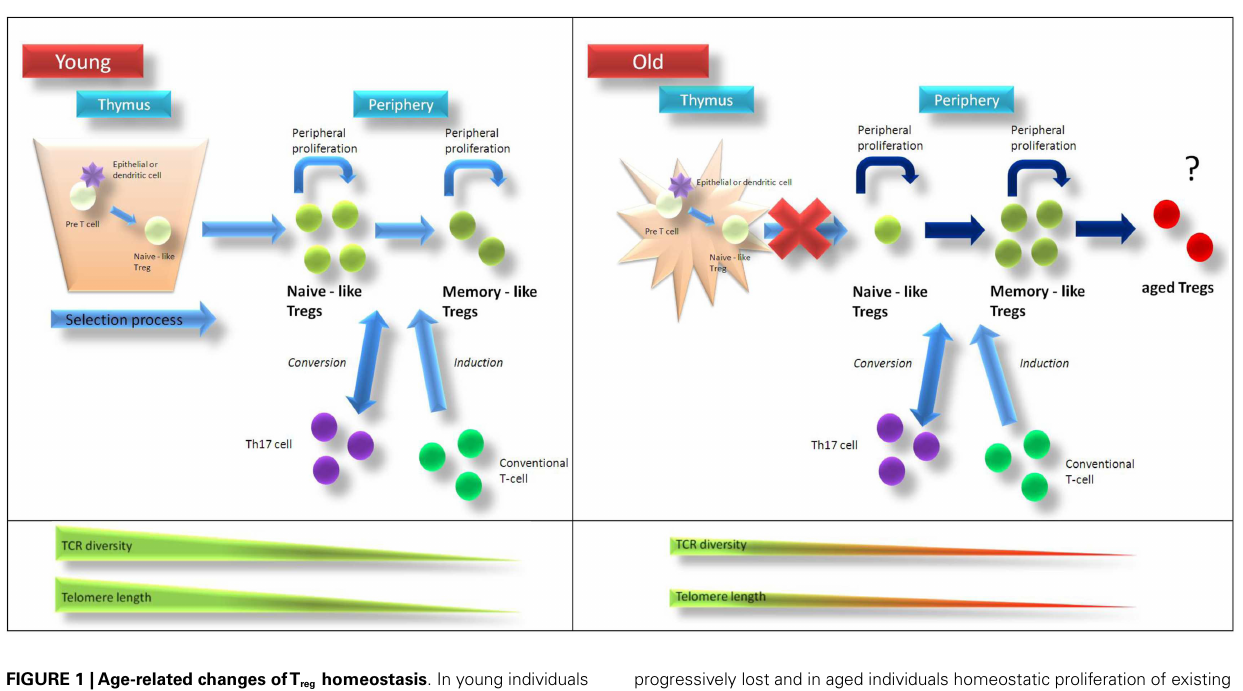
FIGURE 1 |Age-related changes ofT reg homeostasis . In young individuals T regs are generated in the thymus and are released as “naïve-like”T regs into circulation. After antigen-contact,T regs develop into a “memory-like” phenotype.T reg homeostasis is supported by homeostatic proliferation of “naïve-like” and “memory-like”T regs as well as conversion of non-regulatory T-cells intoT regs .Telomere length andT-cell receptor diversity is higher in naïve-like compared to memory-likeT regs . After puberty thymic function is